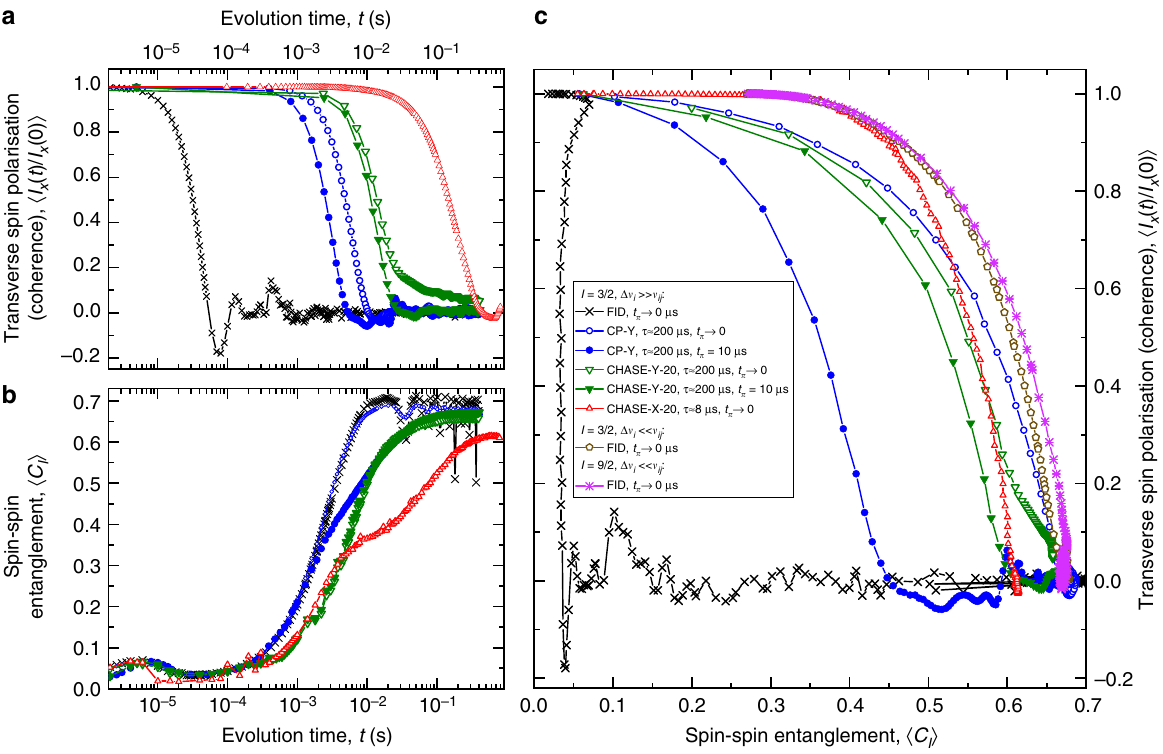
Fig. 5 Simulated evolution of spin coherence and entanglement of a dipolar-coupled nuclear spin bath. Simulations are for the I z = ±1/2 spin subspace under ideal ( t π → 0, open symbols) and fi nite ( t π = 10 μ s, solid symbols) control pulses. a Time evolution of the average transverse magnetisation 〈 I x ( t ) 〉 normalised by the initial magnetisation 〈 I x (0) 〉 for spin-3/2 nuclei with large inhomogeneous broadening Δ ν i ≫ ν ij . Simulations are for free induction decay (FID, initialisation π /2-pulse only) and several cyclic pulse sequences. In the case of the cyclic sequences, 〈 I x ( t ) 〉 is plotted only at the times of spin echoes. Note that the results here are simulated with a constant pulse-to-pulse delay τ , whereas the data in Fig. 2a – c are measured with a constant number n of pulse sequence repeats. b Evolution of the averaged spin – spin entanglement 〈 C I 〉 for the same simulations as in ( a ). c Trajectories in the 〈 C I 〉 − 〈 I x 〉 phase space for the results of ( a ) and ( b ) as well as additional trajectories for small inhomogeneity ( Δ ν i ≪ ν ij ) and spin-9/2